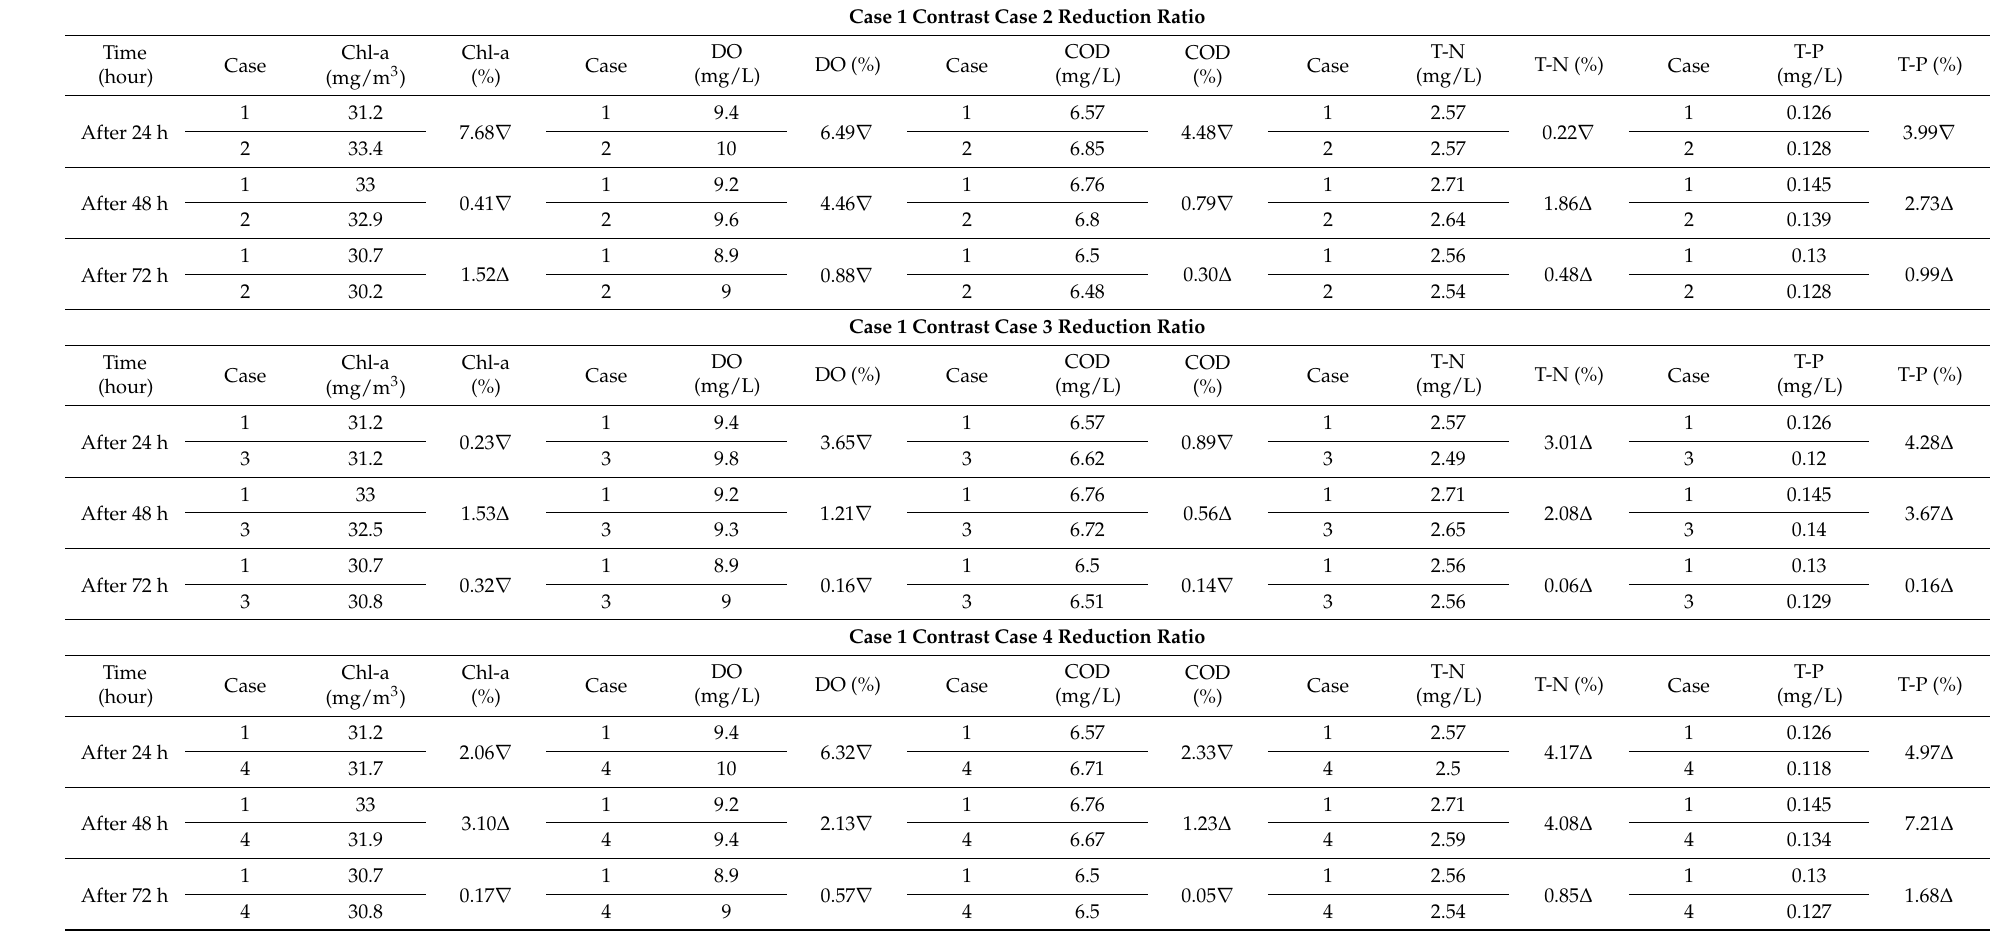
Table 2. Case 1 Contrast Scenario Reduction